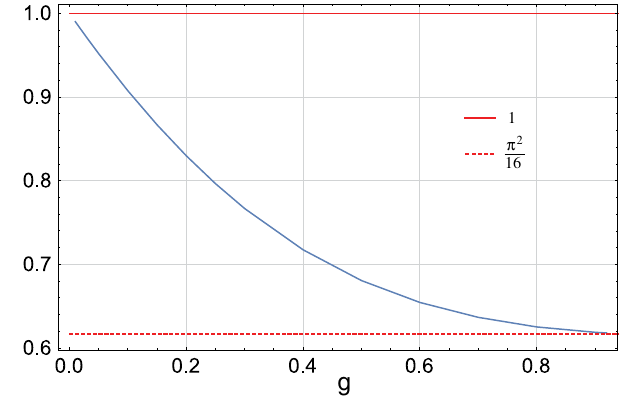
FIG. 5. Longitudinal electric field E elliptical structure normalized by − 2 Q at the particle in a z on the ellipse flattering factor g ¼ 1 − a=b π 2 ; points: results using the mode 16 a 2 π 2 . 16 a 2